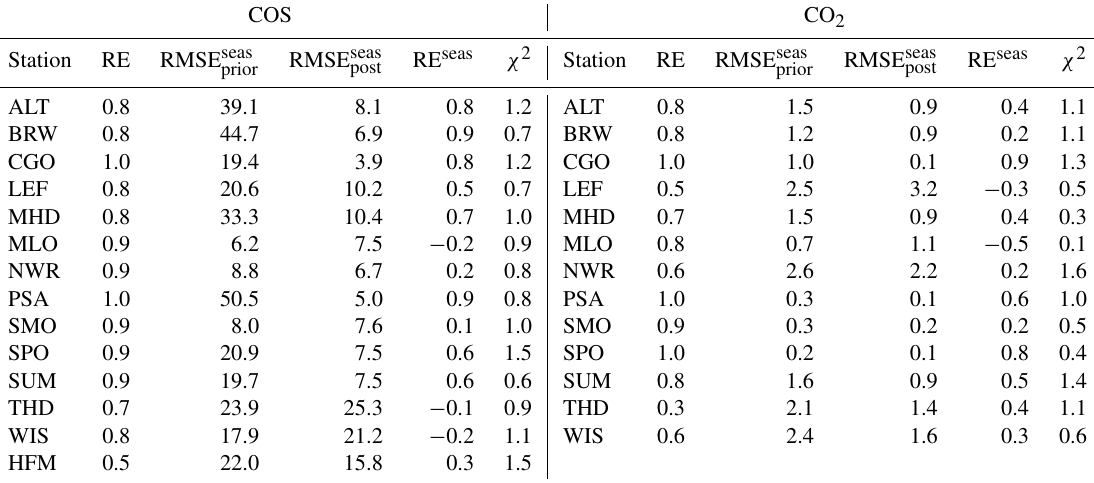
Table 4. Column “RE” presents the fractional reduction of the model vs. assimilated measurement RMSE “RMSE seas ” presents the RMSE of the a priori detrended time series compared to the assimilated measurement time series. Column prior “RMSE seas post ” presents the RMSE of the a posteriori detrended time series. Column “RE seas ” presents the reduction of uncertainties using the RMSE metrics applied to the detrended time series for each station. The detrended curves have been filtered to remove the synoptic variability (see Sect. 2.6). The RMSE is in ppm (ppt) for CO 2 (COS). All statistics are for the period